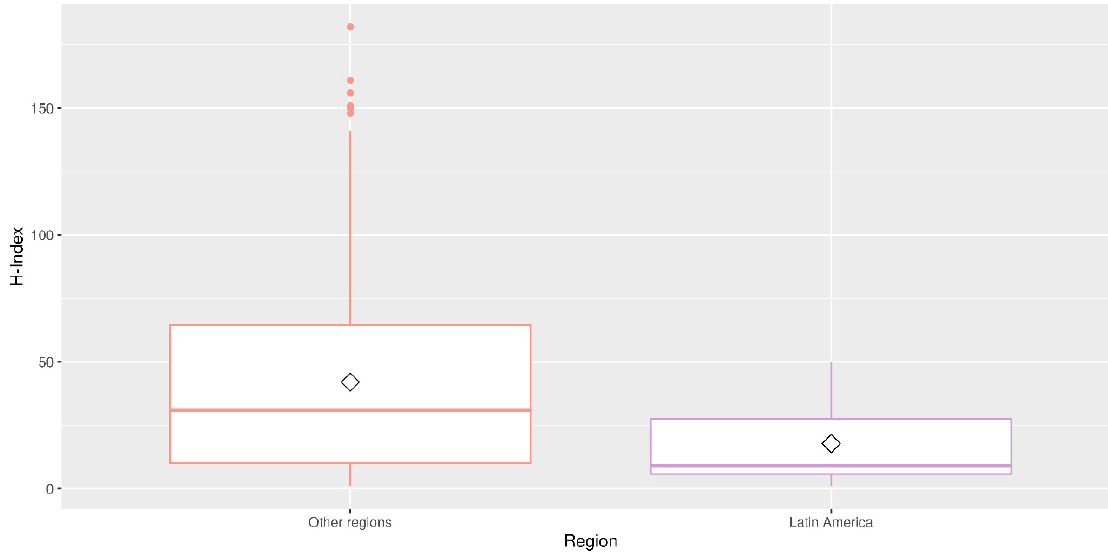
Figure 1. Cullen and Frey graph of the H-Index of journals from LAC and other regions.